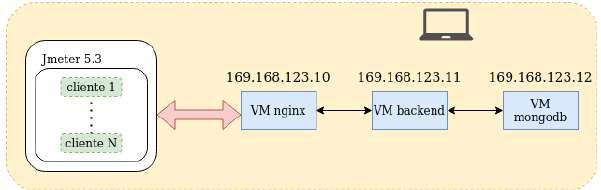
Figure 9. Deployment of the applications on a single